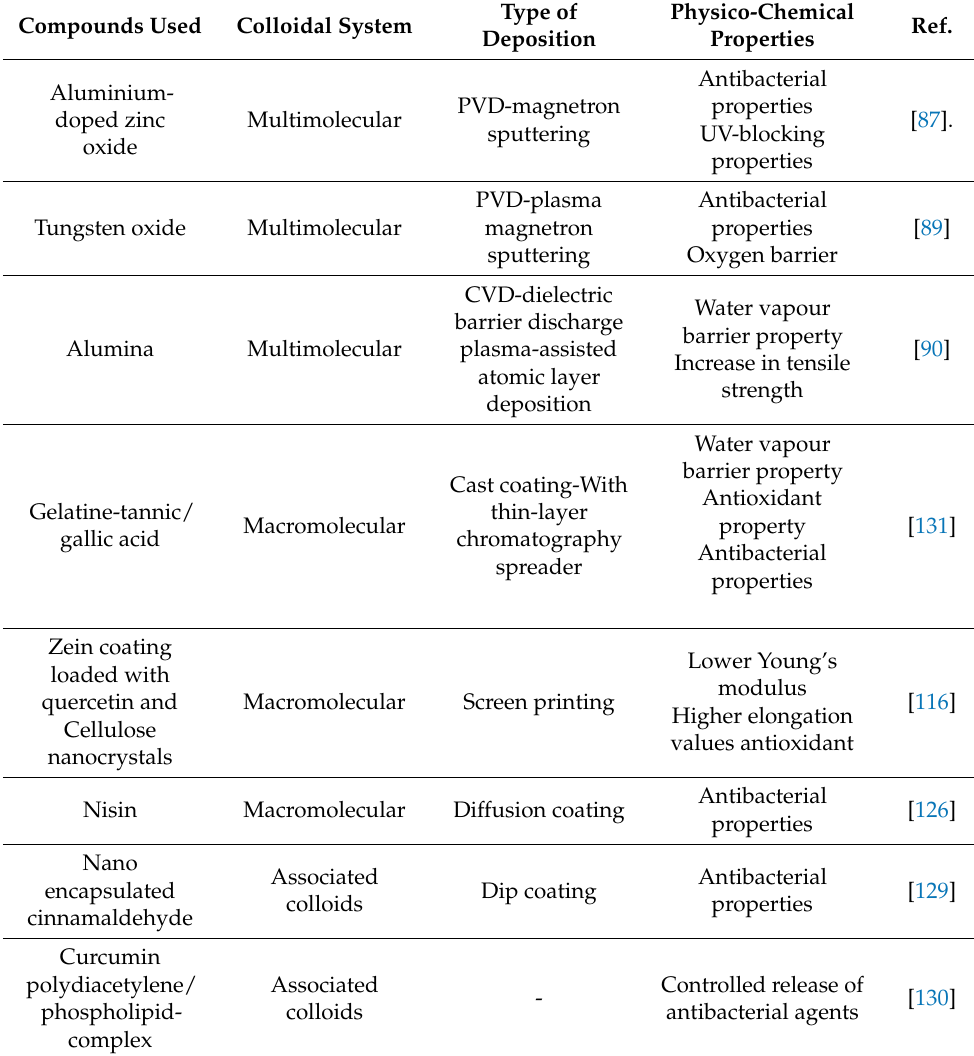
Table 2. Some of the coatings applied on PLA films for active